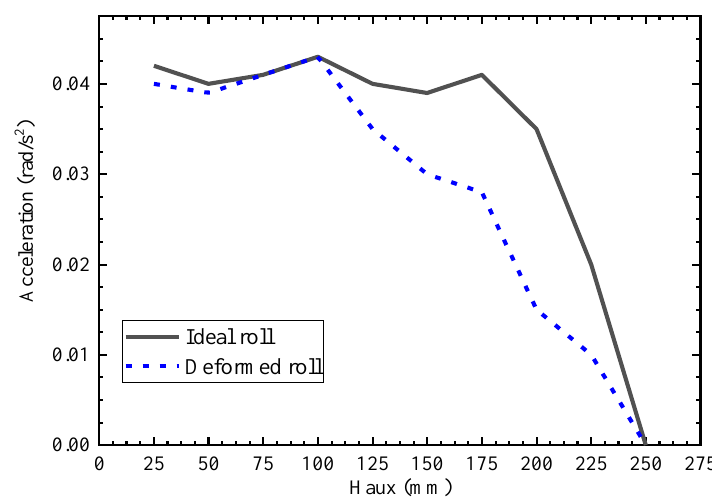
Figure 4. Simulation results of the roll acceleration as a function of the auxiliary wheel height.